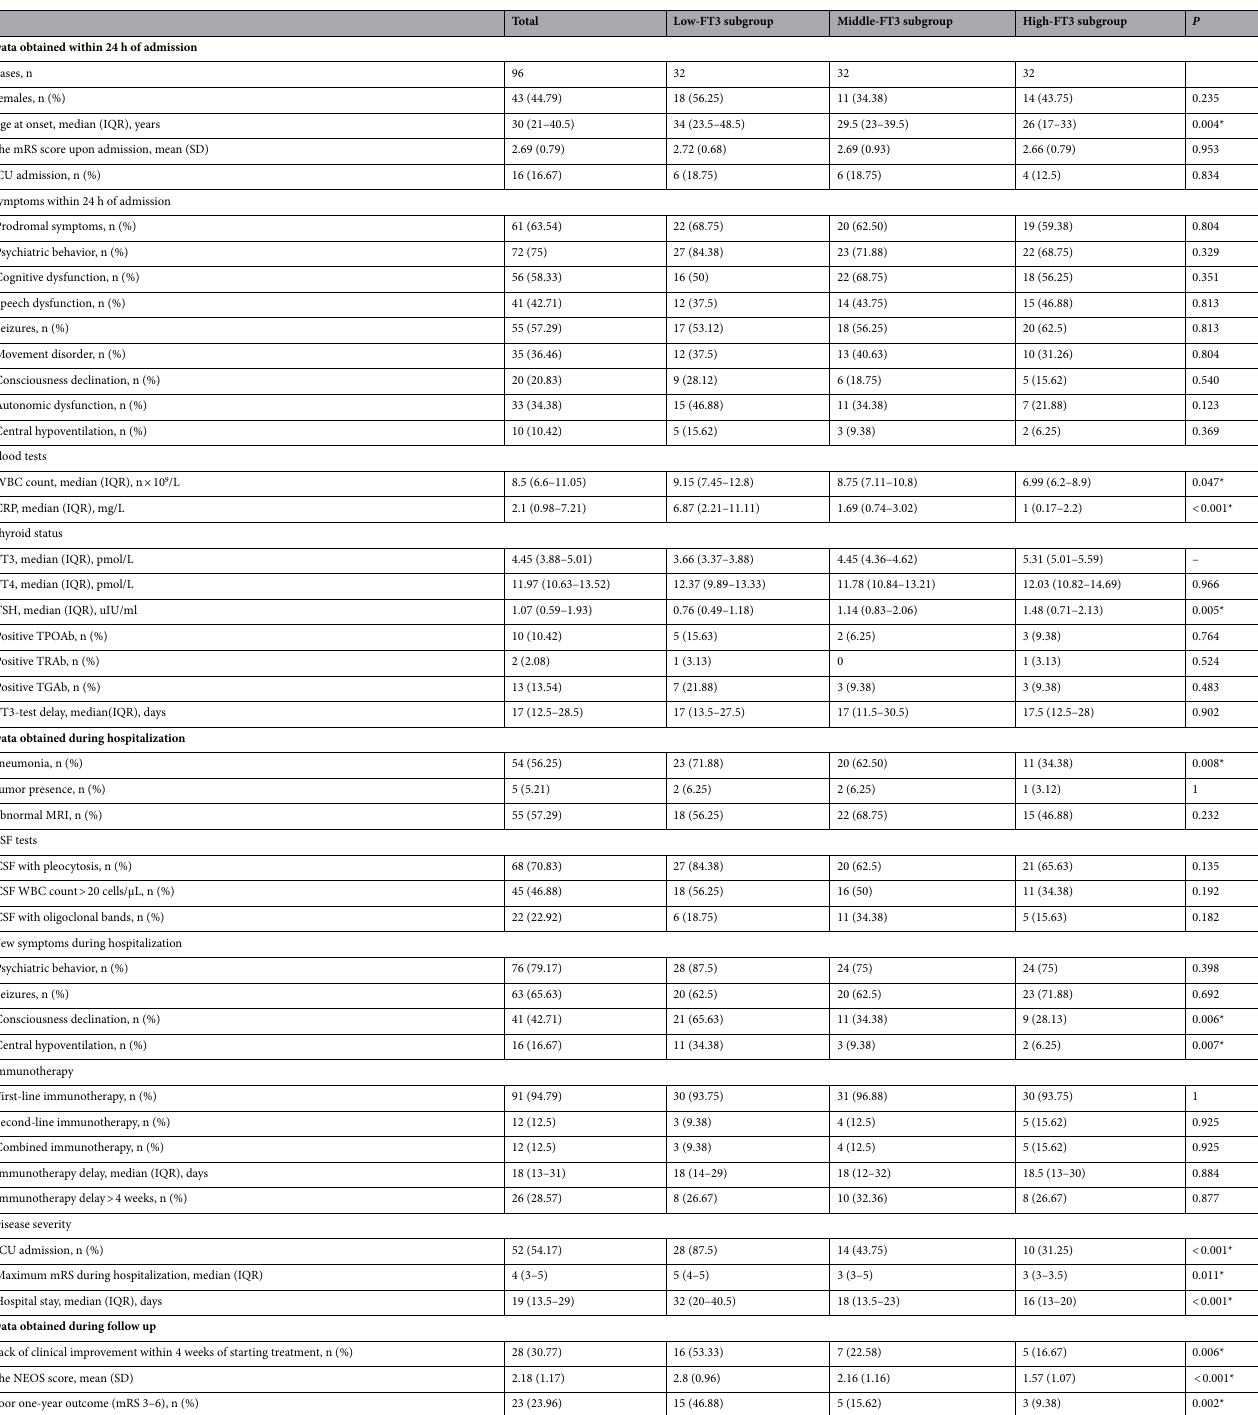
Table 1. Clinical features and subgroup comparisons of the study population. IQR, interquartile range; SD, standard deviation; MRI, magnetic resonance imaging; WBC, white blood cell; CRP, c-reactive protein; CSF, cerebrospinal fluid; FT3, free triiodothyronine; FT4, free thyroxine; TSH, thyroid stimulating hormone; TGAb, anti-thyroglobulin antibodies; TPOAb, anti-thyroid peroxidase antibodies; TRAb, anti-thyroid receptor antibodies; ICU, intense care unit; mRS, modified Rankin scale; NEOS, anti-NMDAR Encephalitis One-Year Functional Status. * P < 0.05. # The new symptoms during hospitalization refer to those firstly manifest after 24 h of